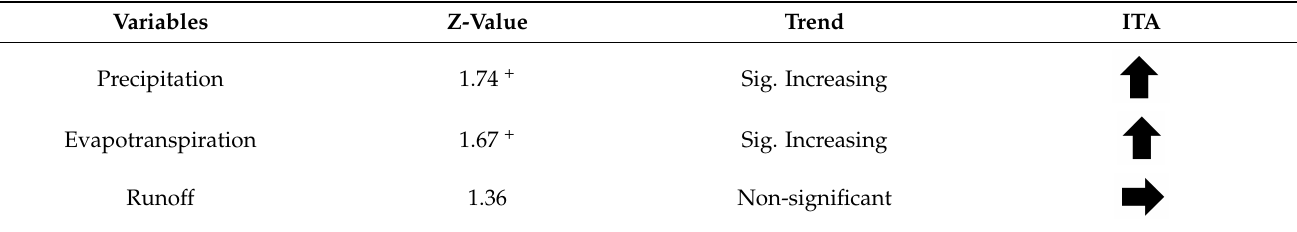
Table 5. Results of the MK trend test and ITA on the annual for the hydro-climatic time series of the KRB. Variables